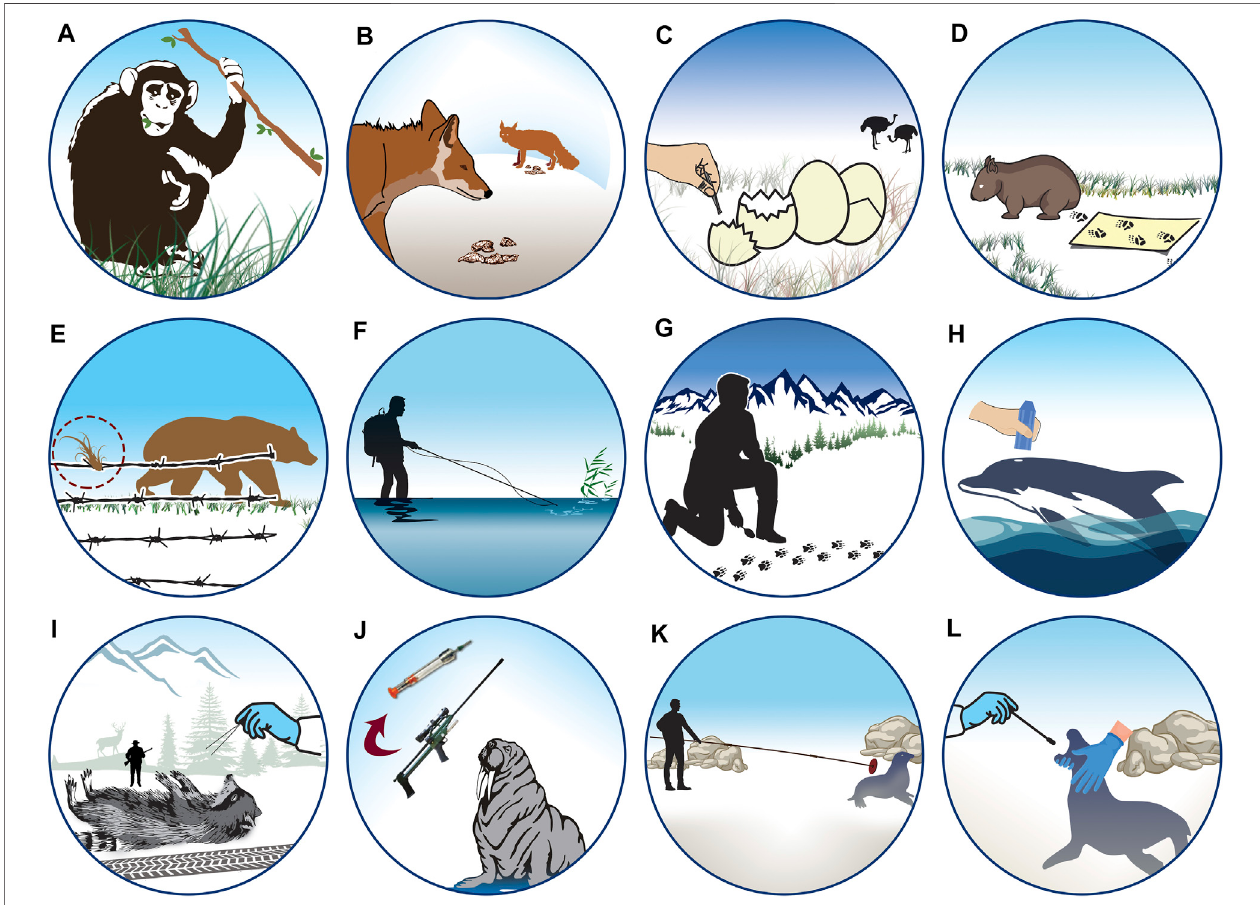
FIGURE 1 | Depiction of some of the major means of non-intrusive eDNA sampling; (A) chewed sticks, (B) faeces, (C) eggshells, (D) adhesive tape trap, (E) hair snare, (F) fi ltering of water, (G) snow imprints, (H) blowhole exhalation, (I) body parts, (J) non-lethal remote dart biopsy, (K) hair stripping discs, (L) oral swabbing.